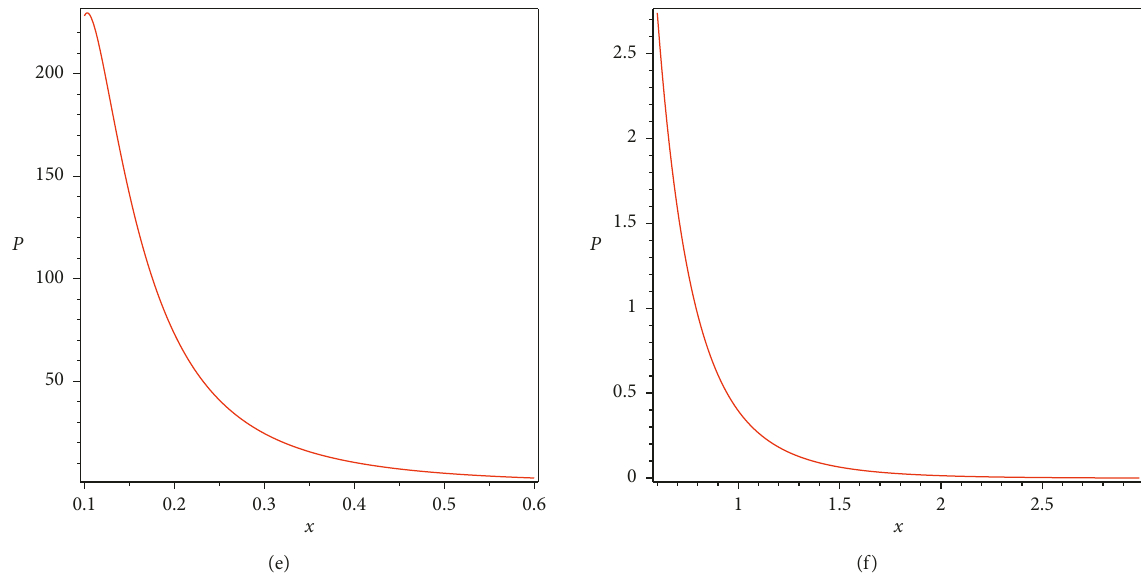
. (b–f) Bifurcation diagram of phytoplankton in 2